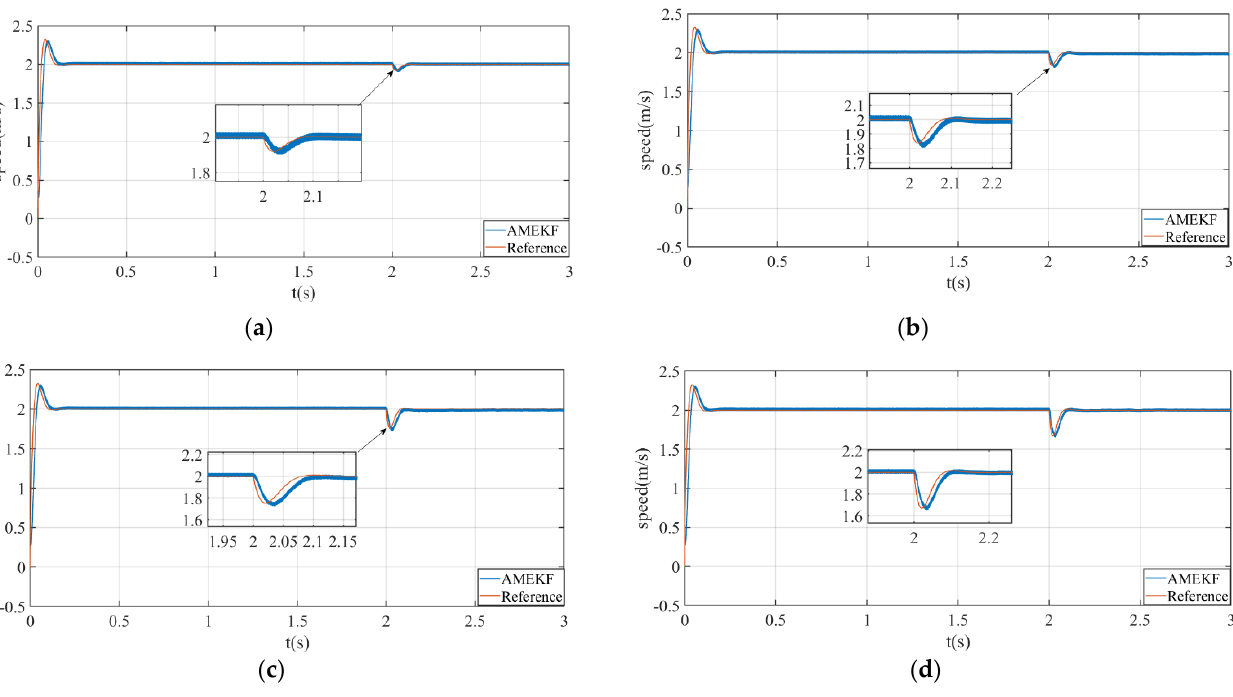
Figure 9. Actual and estimated speeds under different torque loads. ( a ) Sudden 100 N load. ( b ) sudden 200 N load. ( c ) sudden 300 N load. ( d ) sudden 400 N load. The curves of torque versus time of a linear motor with 100 N, 200 N, 300 N, and 400 N loads added at 2 S are shown in Figure